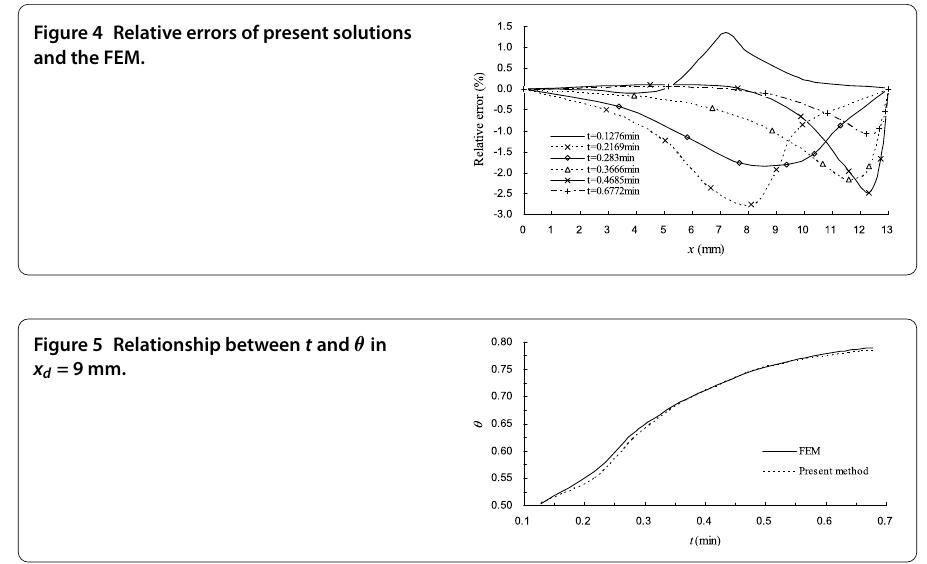
Figure 4 Relative errors of present solutions and the FEM.